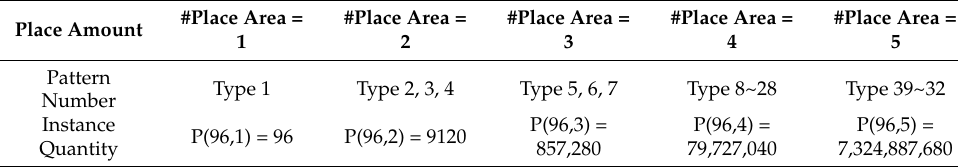
Figure 6. Thirty-two synthesis layout patterns with entrances facing away from the exits. Note: The pattern 10 in red boundary is used to develop layout template. Table 6. The result of permutations with place areas 1–5 and object 96.